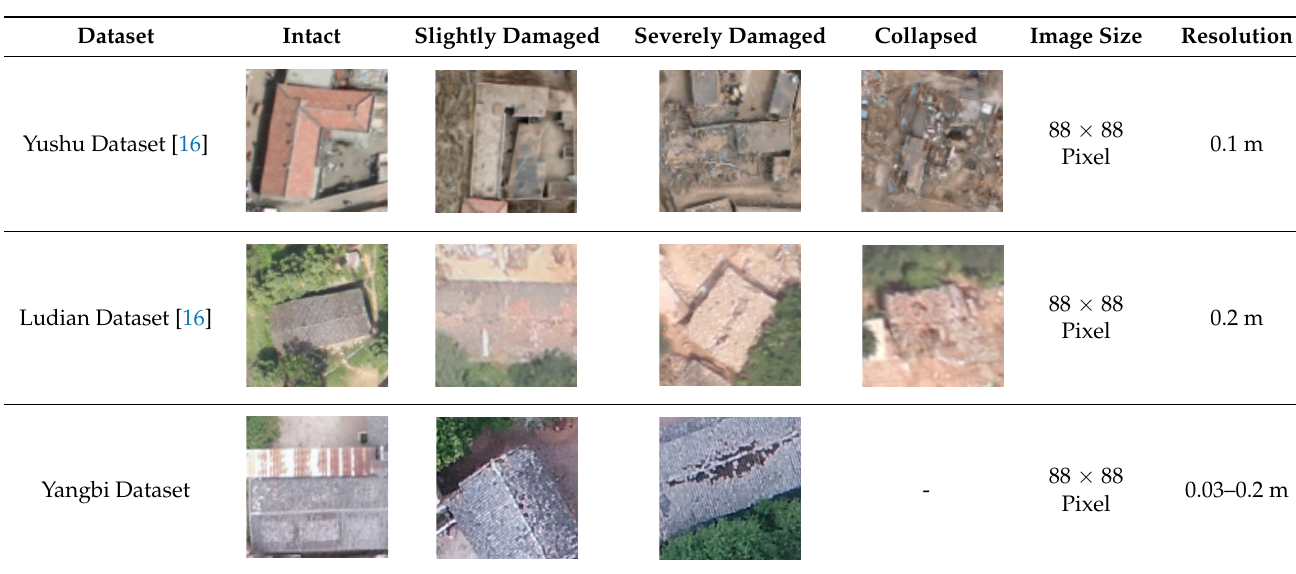
Table 1. Building examples and image information of the four damage levels in the datasets. Table 2, the number of images with four damage levels in the dataset was counted.